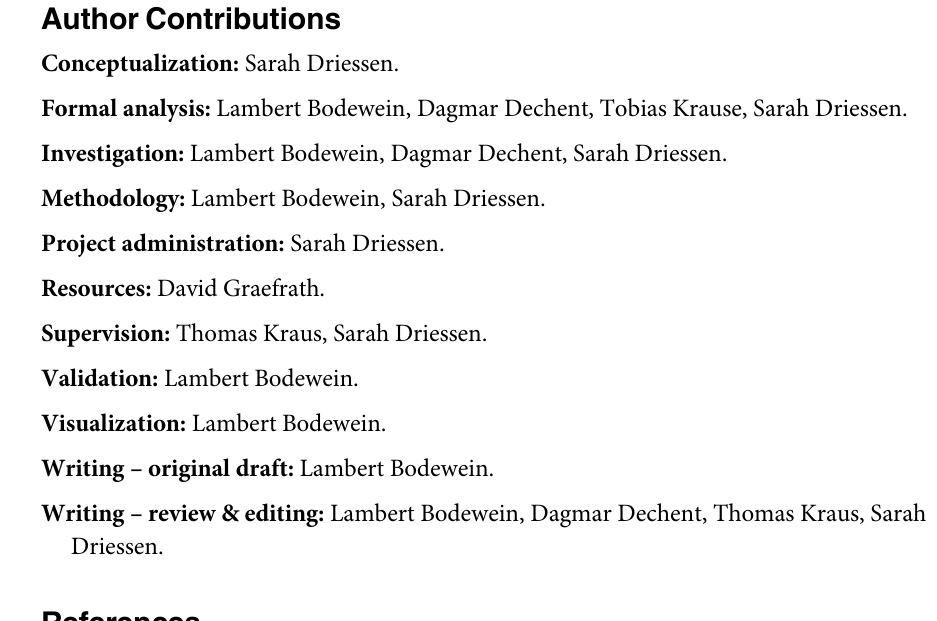
S12 Table. Assessing confidence in the body of evidence in experimental studies (human controlled trials), according to OHAT